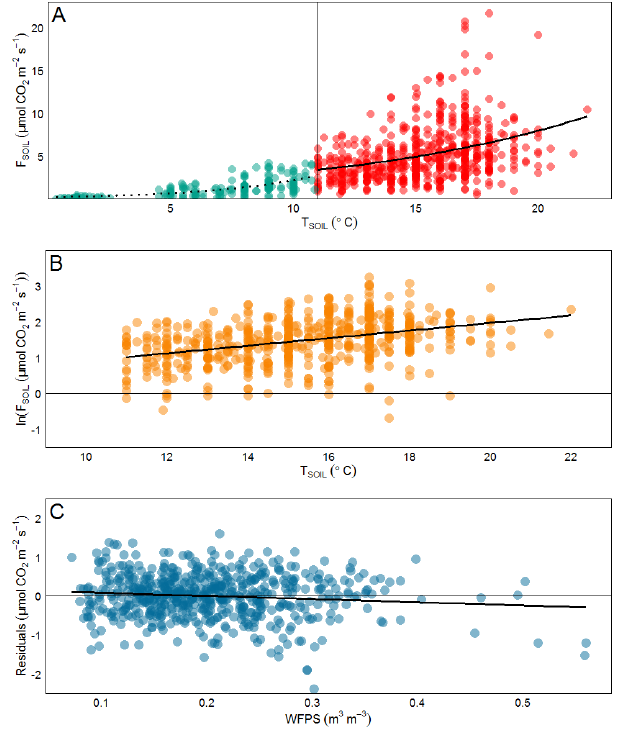
Figure 2. (a) Soil CO 2 efflux (µmol CO 2 m − 2 s − 1 ) against soil temperature ( ◦ C) at 12cm with data split at 11 ◦ C. For all data, exponential regression shows an R 2 = 0.3163. For flux rate values below 11 ◦ C, R 2 = 0.434; for flux rate values above 11 ◦ C, R 2 = 0.104. (b) Natural log of soil CO 2 efflux (µmol CO 2 m − 2 s − 1 ) against soil temperature ( ◦ C) at 12cm for all data above 11 ◦ C. For flux rate values below 11 ◦ C, linear regression gives an R 2 = 0.1188, with p = <<0.001. (c) Residuals of the nat- ural log of soil CO 2 efflux (µmol CO 2 m − 2 s − 1 ) against water- filled pore space (0–12cm) for all data above 11 ◦ C. R 2 = 0.0208; p =